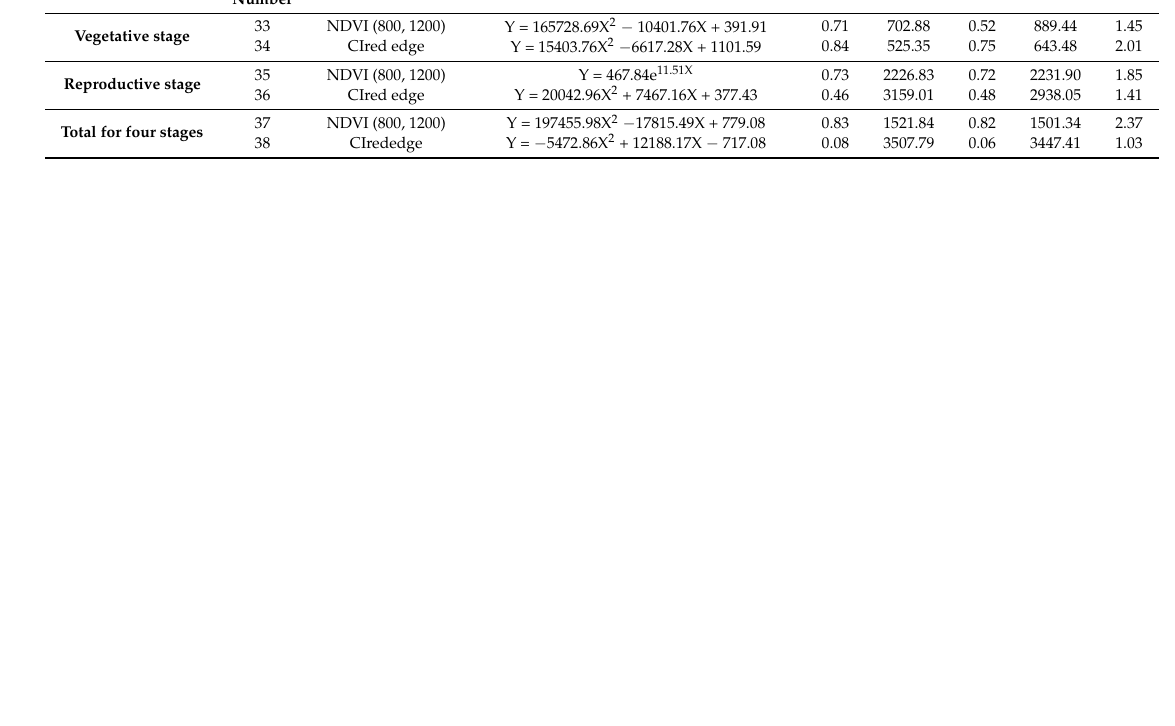
Table 7. Regression modeling analysis between NDVI (800, 1200), CIred edge, and AGB. Growth